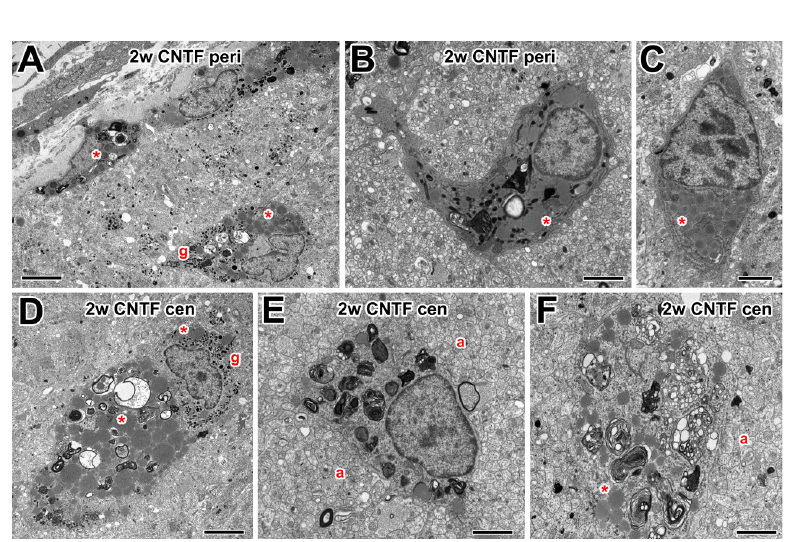
Fig 6. Electron microscopy of macrophages in 2 w CNTF-treated nerve. (A) Low power electron micrograph of the optic nerve periphery, showing macrophages containing some multilamellar bodies, also lipid inclusions (asterisks) and small dark granules (g). (B) Peripheral microglia-like cell containing multilamellar bodies and lipid inclusions (asterisk). (C) Peripheral unknown cell type containing rough endoplasmic reticulum and lipid inclusions (asterisk). (D) Large, centrally located macrophage with multilamellar bodies, vacuoles containing axonal debris, and lipid inclusions (asterisks). Around its nucleus are numerous dark granules (g). (E) Central macrophage/microglia with multilamellar bodies, in close proximity to many small axons (a). (F) Macrophage with multilamellar bodies and lipid inclusions, in proximity to axons (a). Scale bar: 5 μ m in A, D; 2 μ m in B, C, E, F.